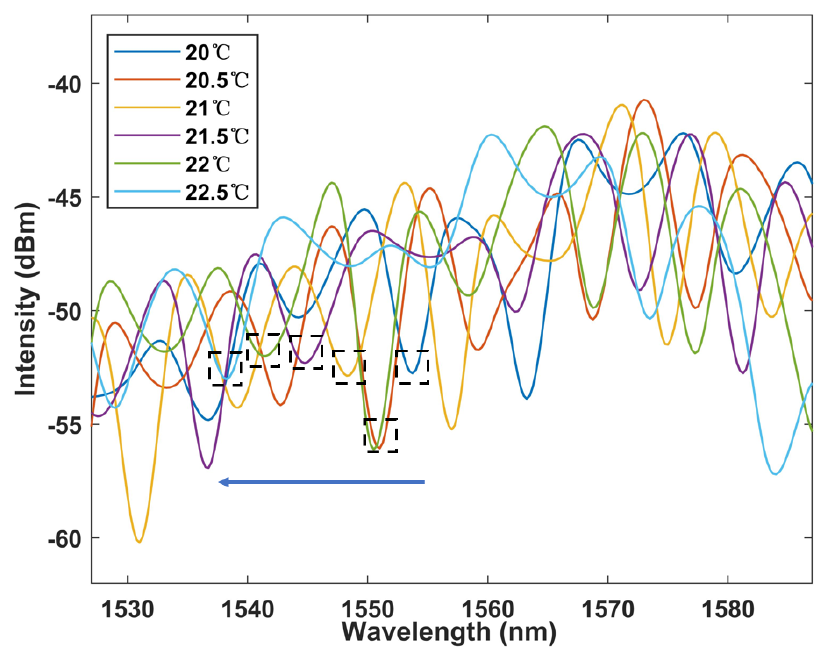
Figure 8. Temperature dependent envelope spectral output characteristics of cascaded Sagnac rings.